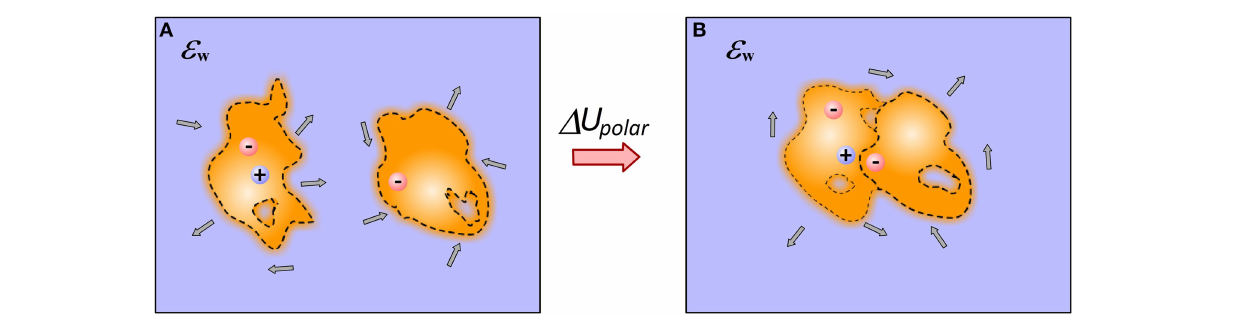
FIGURE 2 | Cartoon presentation of the details of modeling polar solvation energy in case of end-point approaches. (A) Monomers; (B) Complex. For illustration, several water dipoles are shown in the water